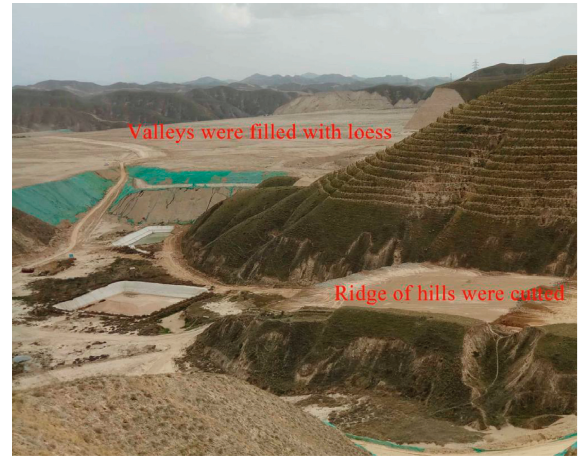
Figure 2: Land creation